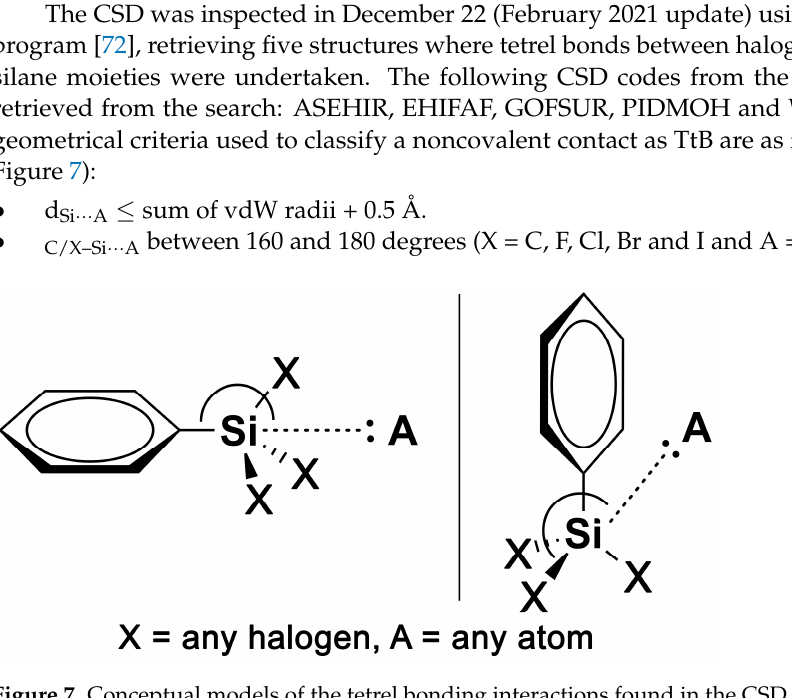
Figure 7. Conceptual models of the tetrel bonding interactions found in the CSD.